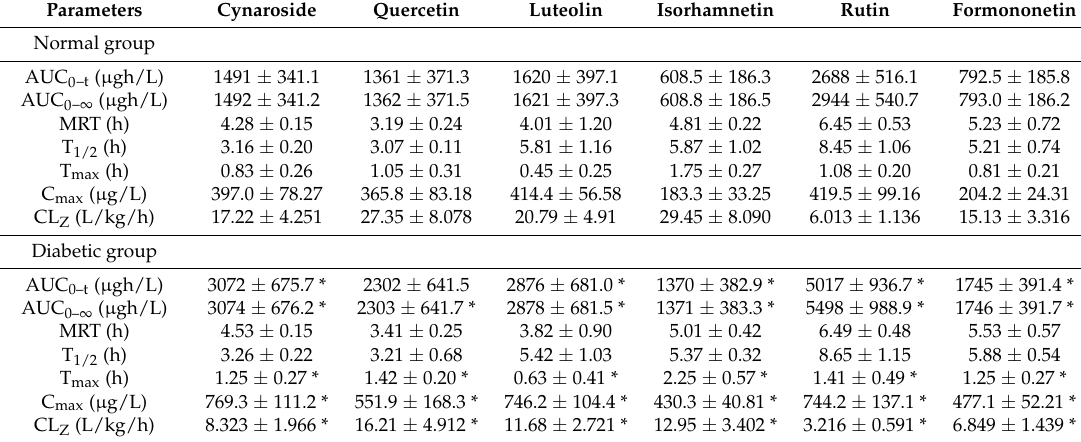
Table 4. Main pharmacokinetic parameters of the six flavonoids after oral administration of Maydis stigma decoction at 5 g · kg − 1 to rats in type 2 diabetic group, * p < 0.05 compared with normal group. (mean ± SD; n =